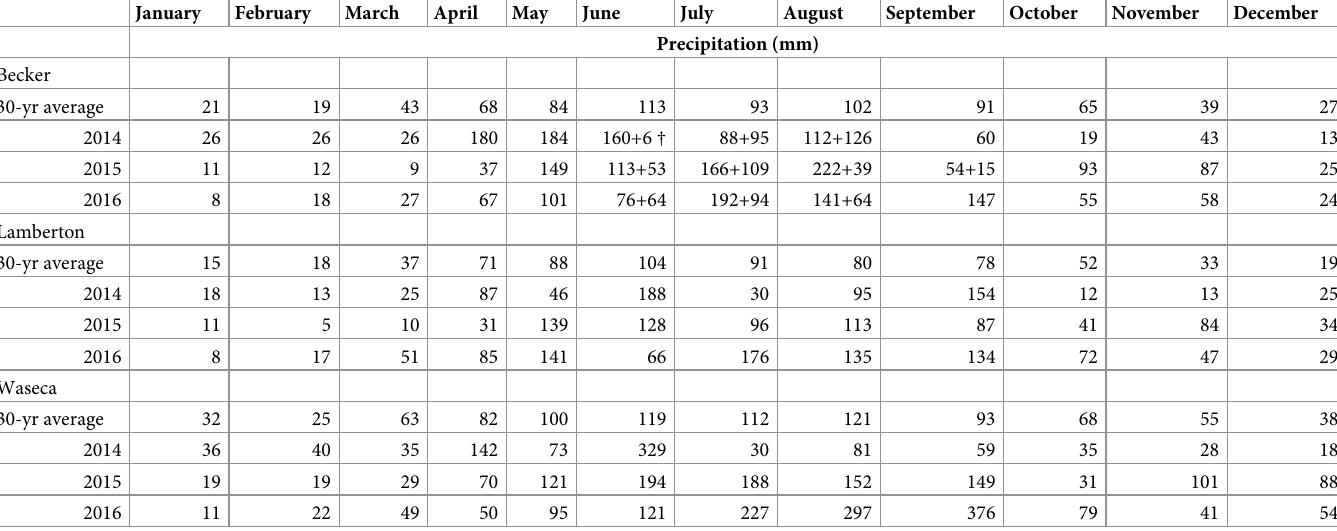
Table 1. Monthly total precipitation during 2014 to 2016 and the 30-yr (1981–2010) average for Becker, Lamberton, and Waseca, MN.